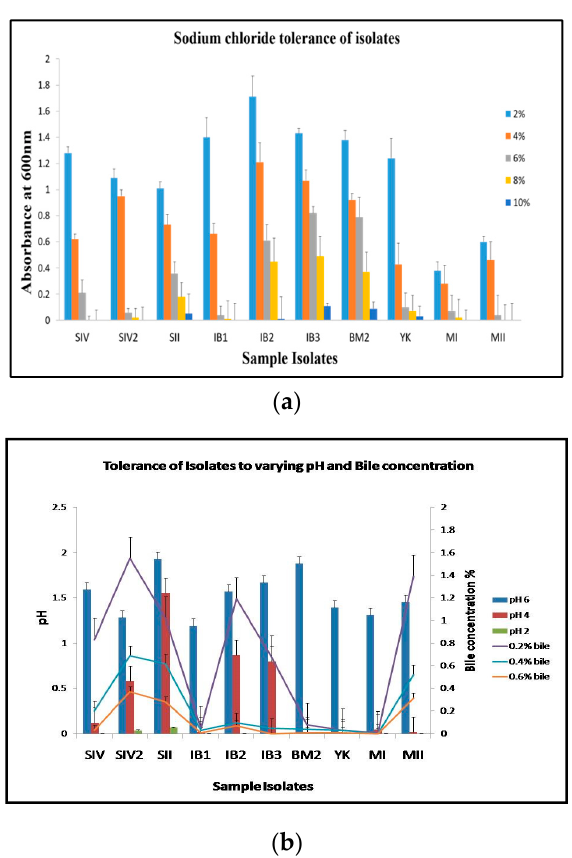
Figure 1. ( a ) Sodium chloride tolerance of isolates at different concentrations and ( b ) bile salt and pH tolerance of isolates at different concentrations of bile and pH values,